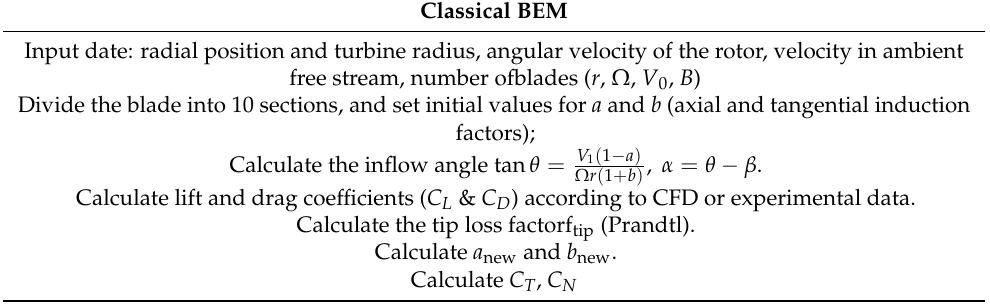
Figure 2. Span locations for blade. Table 1. Classical